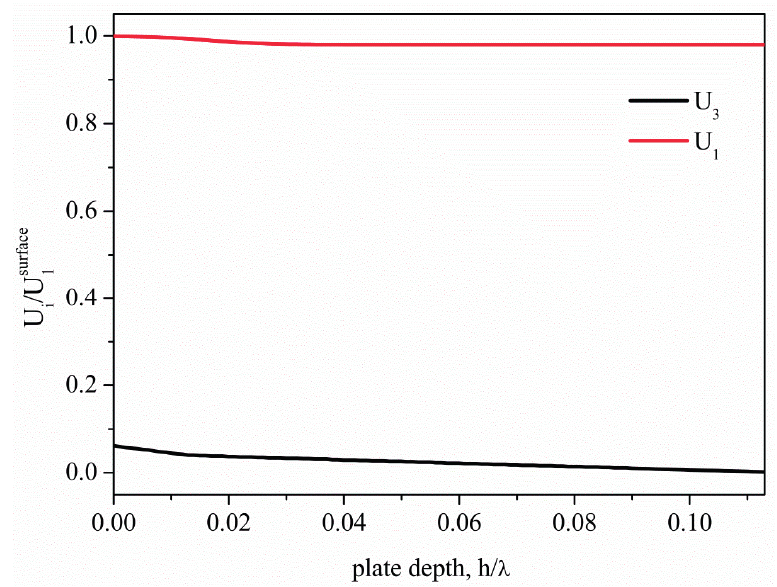
Figure 3. Depth profile of the AM propagating along the BN/AlN composite plate with h BN / λ = 0.1 and h AlN / λ = 0.013.